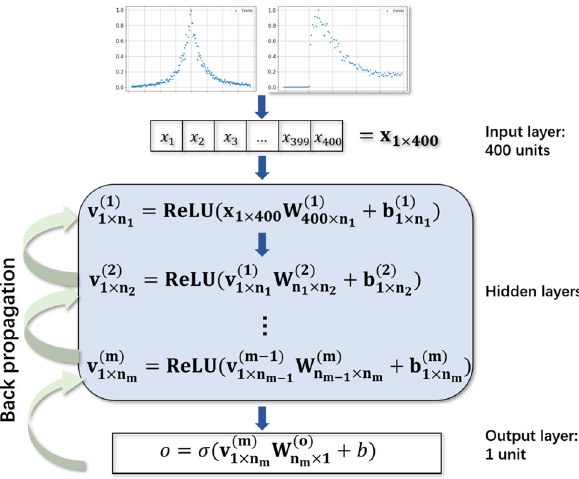
Fig. 2 The process of a sample x crossing the neural network